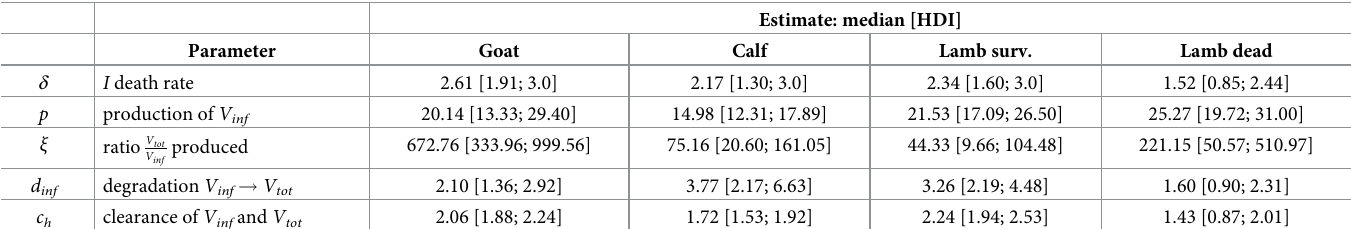
Table 2. Parameter estimates per host group. Median of joint posterior distributions (3 chains) and HDI = highest density interval (95%). All parameters are in unit day -1 , see Materials and methods and Table 1 for detailed definitions. The HDI is built such as every point inside the interval has higher credibility than any point outside the interval [42].